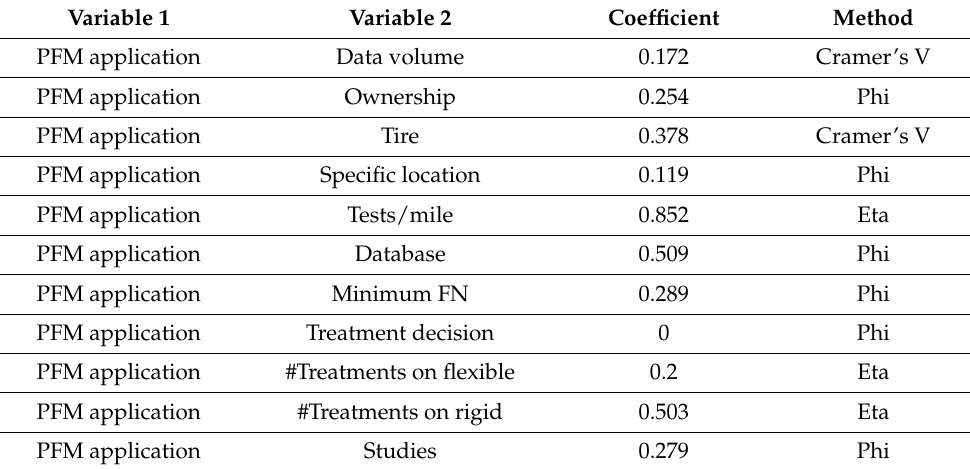
Table 6. Correlation results between the policy of applying PFM and related